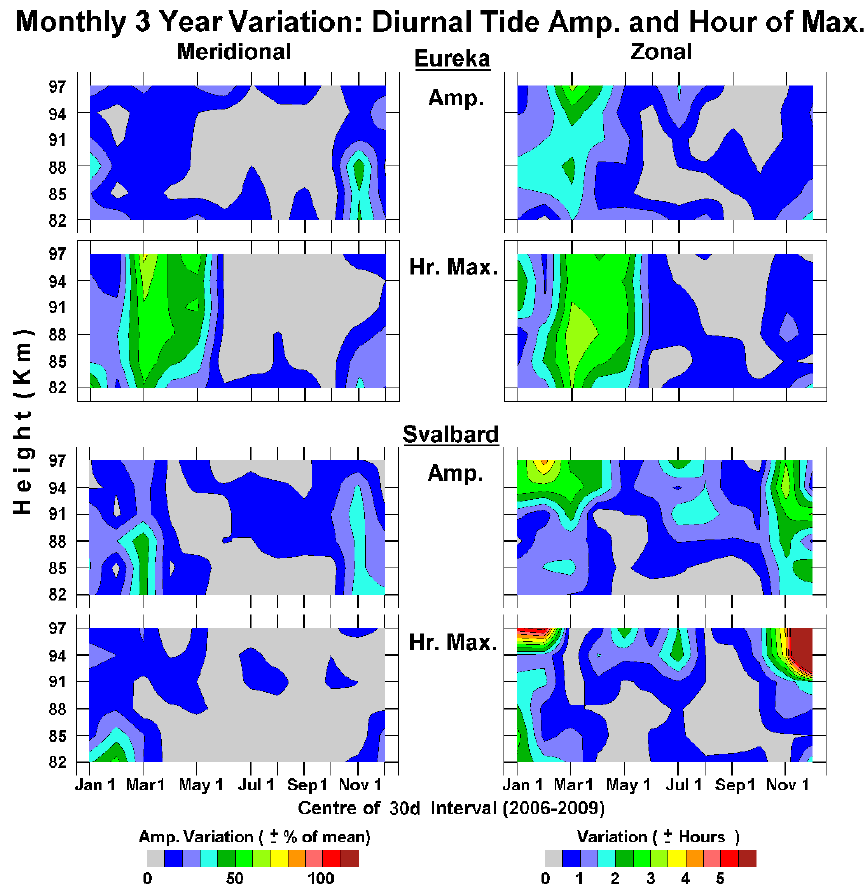
Fig. 2. The “variation” of 24-h tidal amplitudes and phases (local times of maximum), over three years (February 2006 to February 2009), are provided. The “variation” of amplitude is: [100(maximum − minimum)/(maximum + minimum)]%, and of phase in hours is: [(maxi- mum − minimum)/2]. Separate calculations for amplitudes and phases were done for the